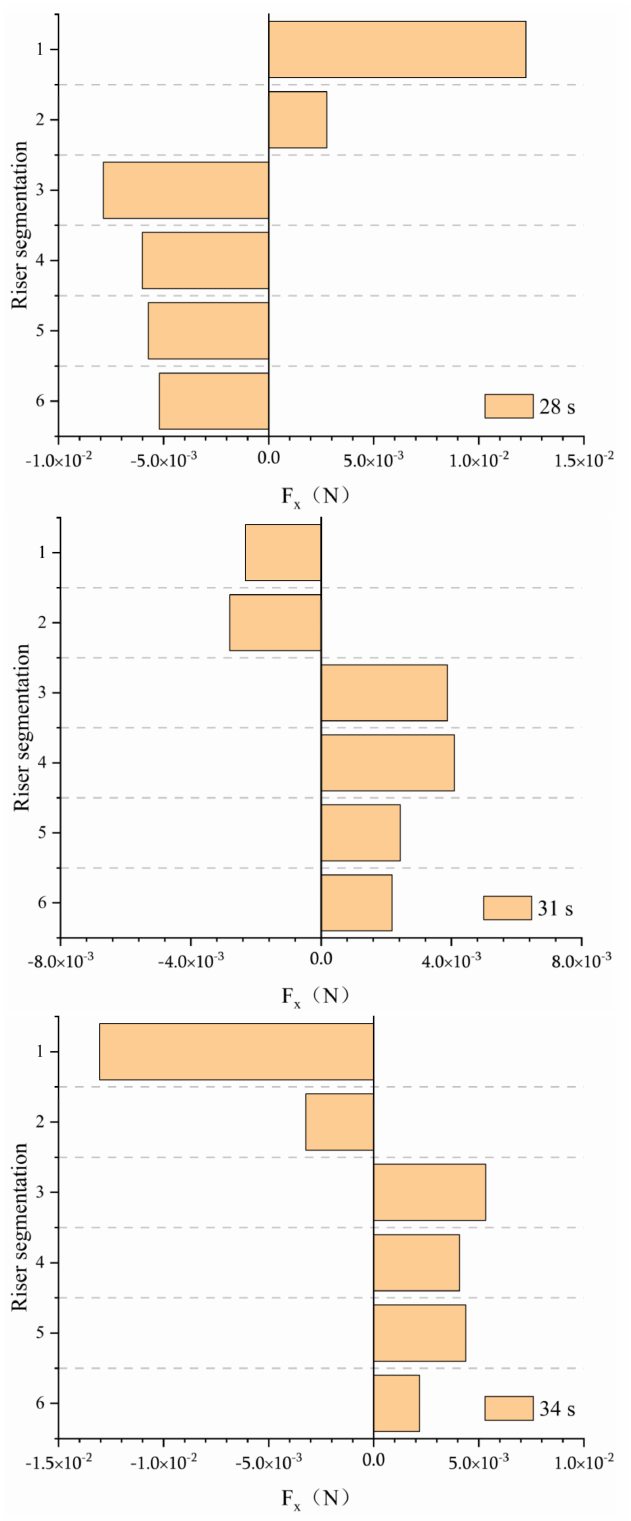
Figure 14. Vertical distribution of force on riser segments at different moments (working condition